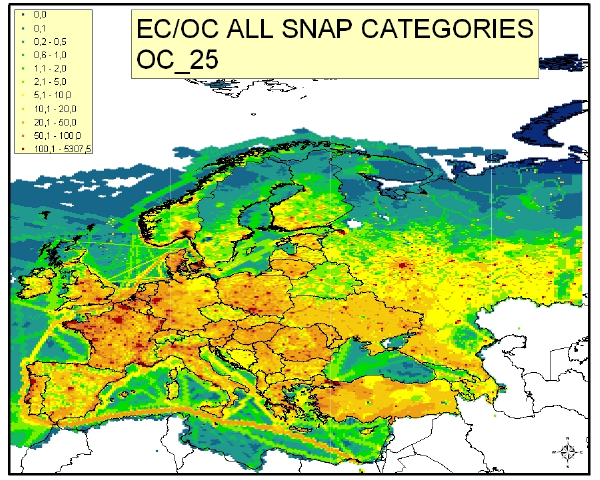
Fig. 1. Emission intensity pattern of OC in PM 2 . 5 over Europe (low to high: blue, green, yellow, orange, red). Unit: tonnesgridcell − 1 yr − 1 .